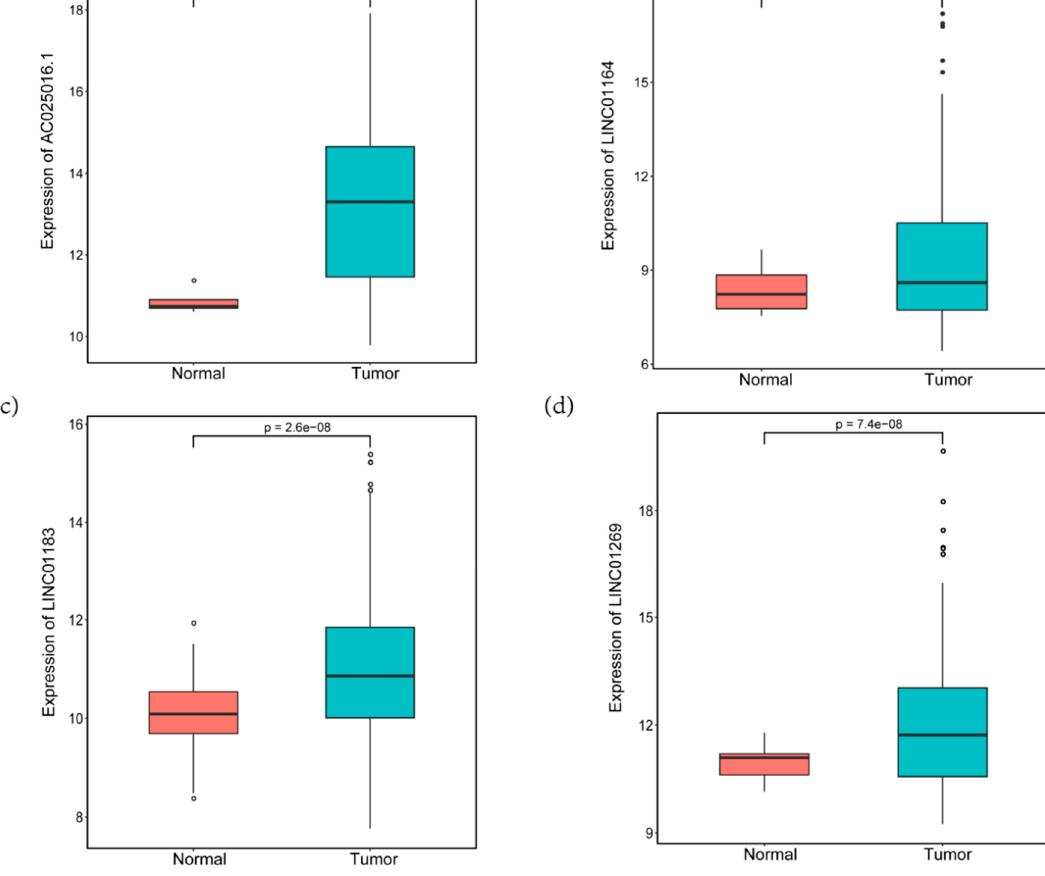
Figure 4. The expression of four hypomethylated lncRNAs in HCC and normal tissues. ( a ) AC025016.1, ( b ) LINC01164, ( c ) LINC01183; ( d )